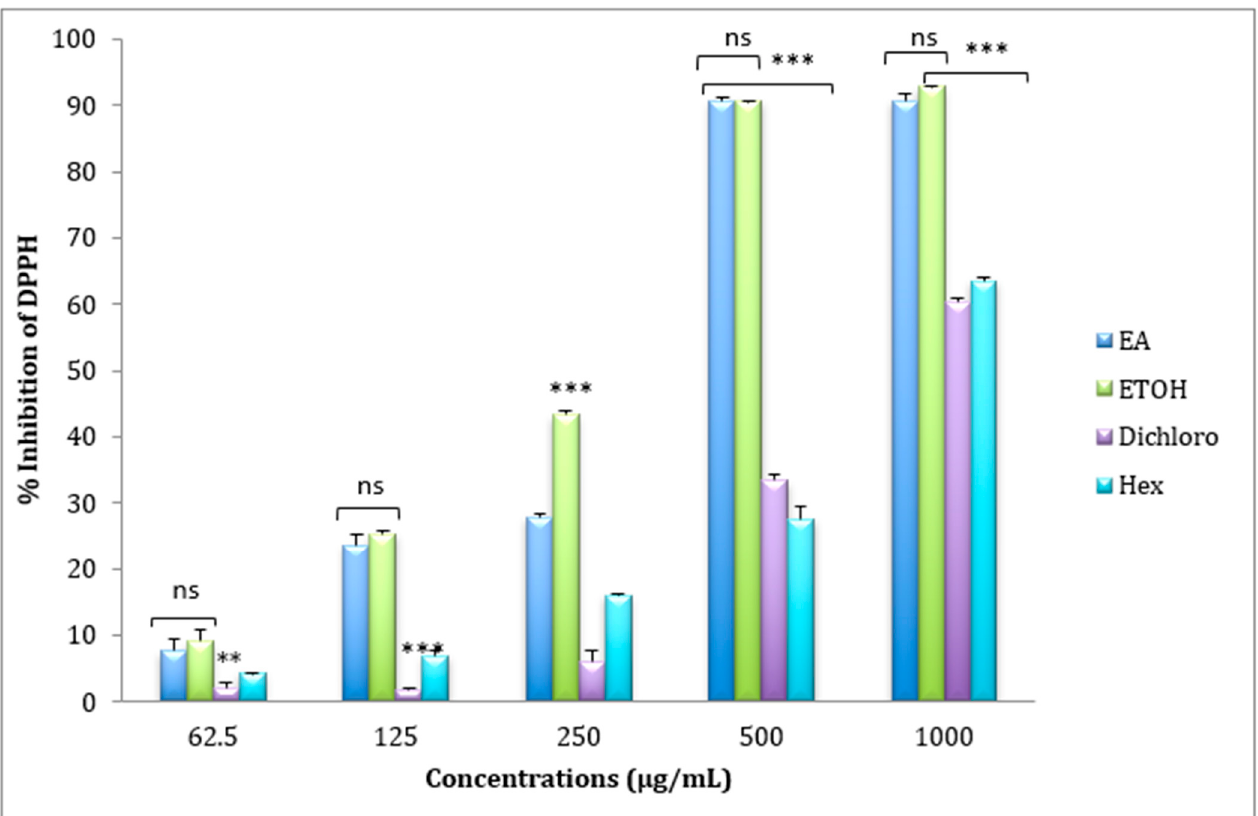
Figure 1. Scavenging effects of Cistus ladanifer Ethyl Acetate (E.A), Ethanolic (ETOH), Dichloromethane (Dichloro), and Hexanic (Hex) extracts on DPPH radicals (mean ± SD, n = 3 experiments, ns: not significant, p values; **: p < 0.01, *** p < 0.001).